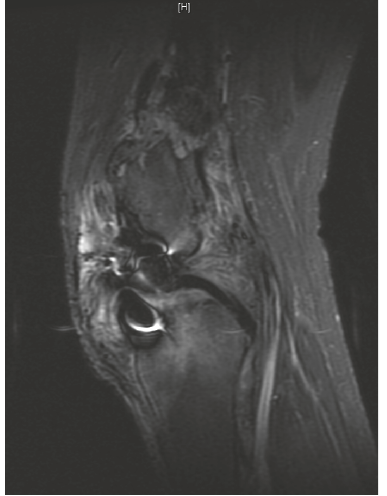
Figure 6: Sagittal STIR MRI of left knee with fracture nonunion of distal femur, marked synovitis, and bony changes consistent with osteomyelitis versus reactive